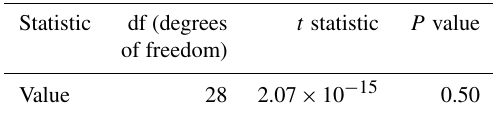
Table E1. Table displaying t -test results for the 2019 drought period risk assessment versus literature